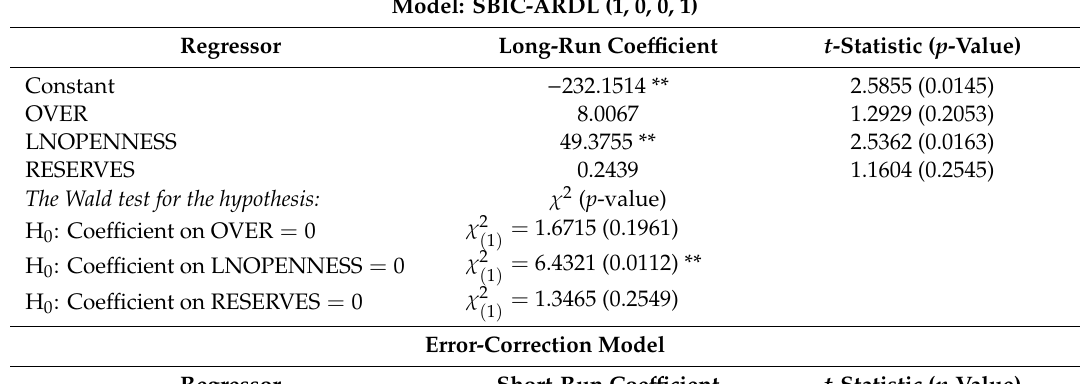
Table 6. Estimated coe ffi cients of the overvaluation dummy (OVER) and other determinants of KF. Model: SBIC-ARDL (1, 0, 0, 1) Regressor Long-Run Coe ffi cient t -Statistic ( p -Value) Constant